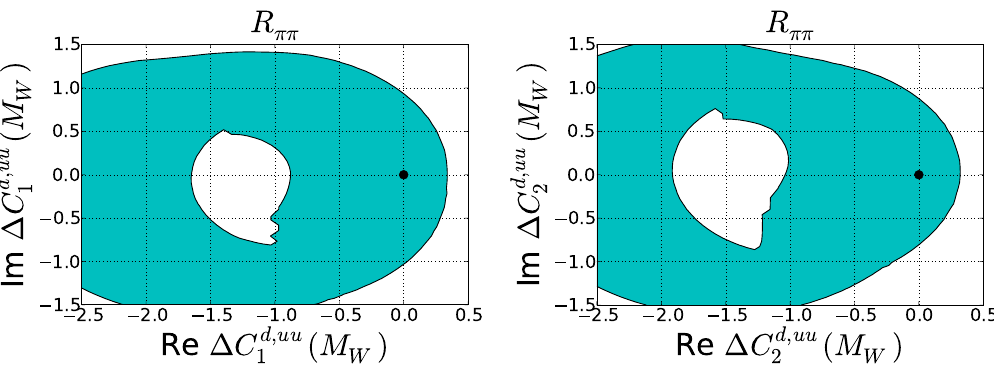
Figure 7 . Potential regions for the NP contributions (cid:1) C d;uu the observable R (cid:25)(cid:25) at 90% C.L. . The black point corresponds to the SM value. The dependence of R (cid:25)(cid:25) is symmetric in C 1 and C 2 , therefore both Wilson coe(cid:14)cients are constrained in an almost identical